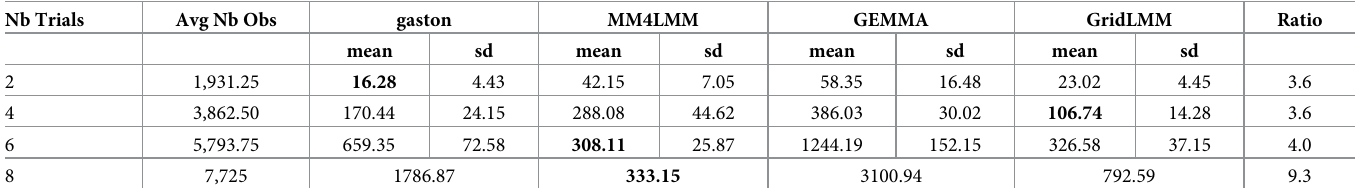
Table 3. Computational time (in sec.) associated to the analysis of different subsamples of trials of the NAM dataset, using Model (2). Bold numbers correspond to the best performance. Nb Trials Avg Nb Obs